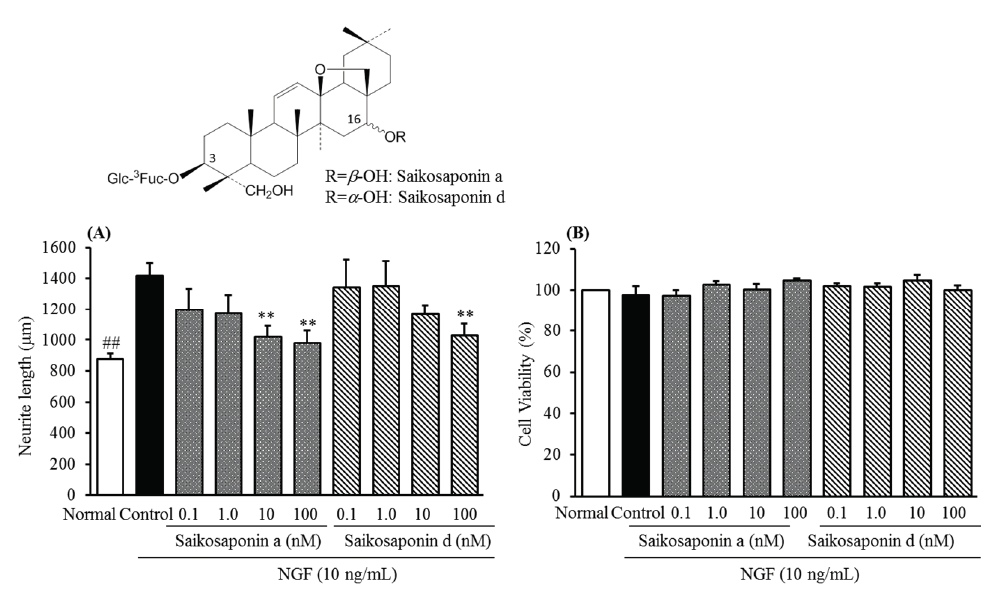
Figure 5. Chemical structures of saikosaponin a, d and their inhibitory activities against NGF-induced neurite growth ( A ) and cell cytotoxicity in cultured DRG neurons ( B ). Values are the means ± S.E.M. of triplicate or quadruplet experiments. ## p < 0.01 vs . Control (Student’s t -test); ** p < 0.01 vs. Control (Dunnett’s